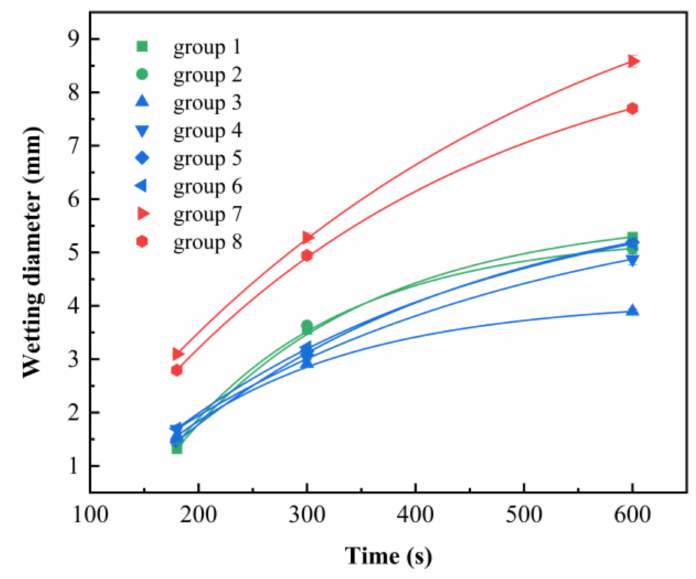
Figure 4. Variation curves of molten CMAS wetting diameter with